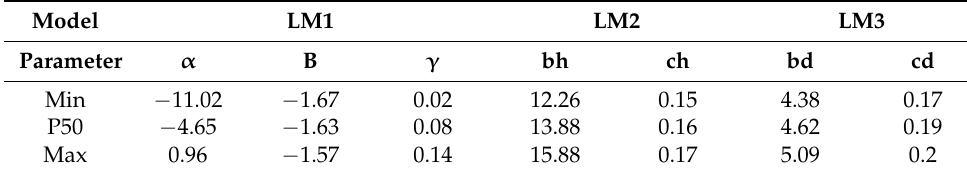
Table 6. Results of the calibration for logistic